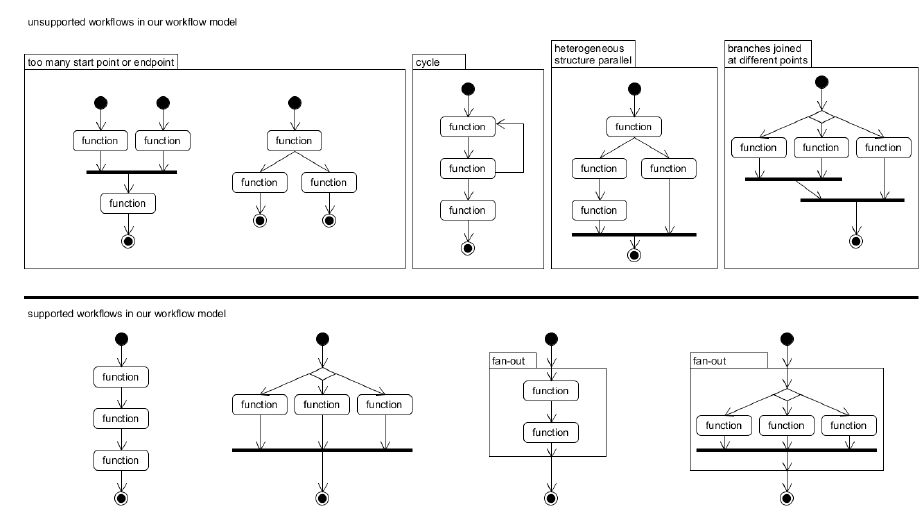
Figure 4. Upper five workflows are examples of unsupported workflows. The title of red boxes show why they are unsupported. Lower four workflow are supported